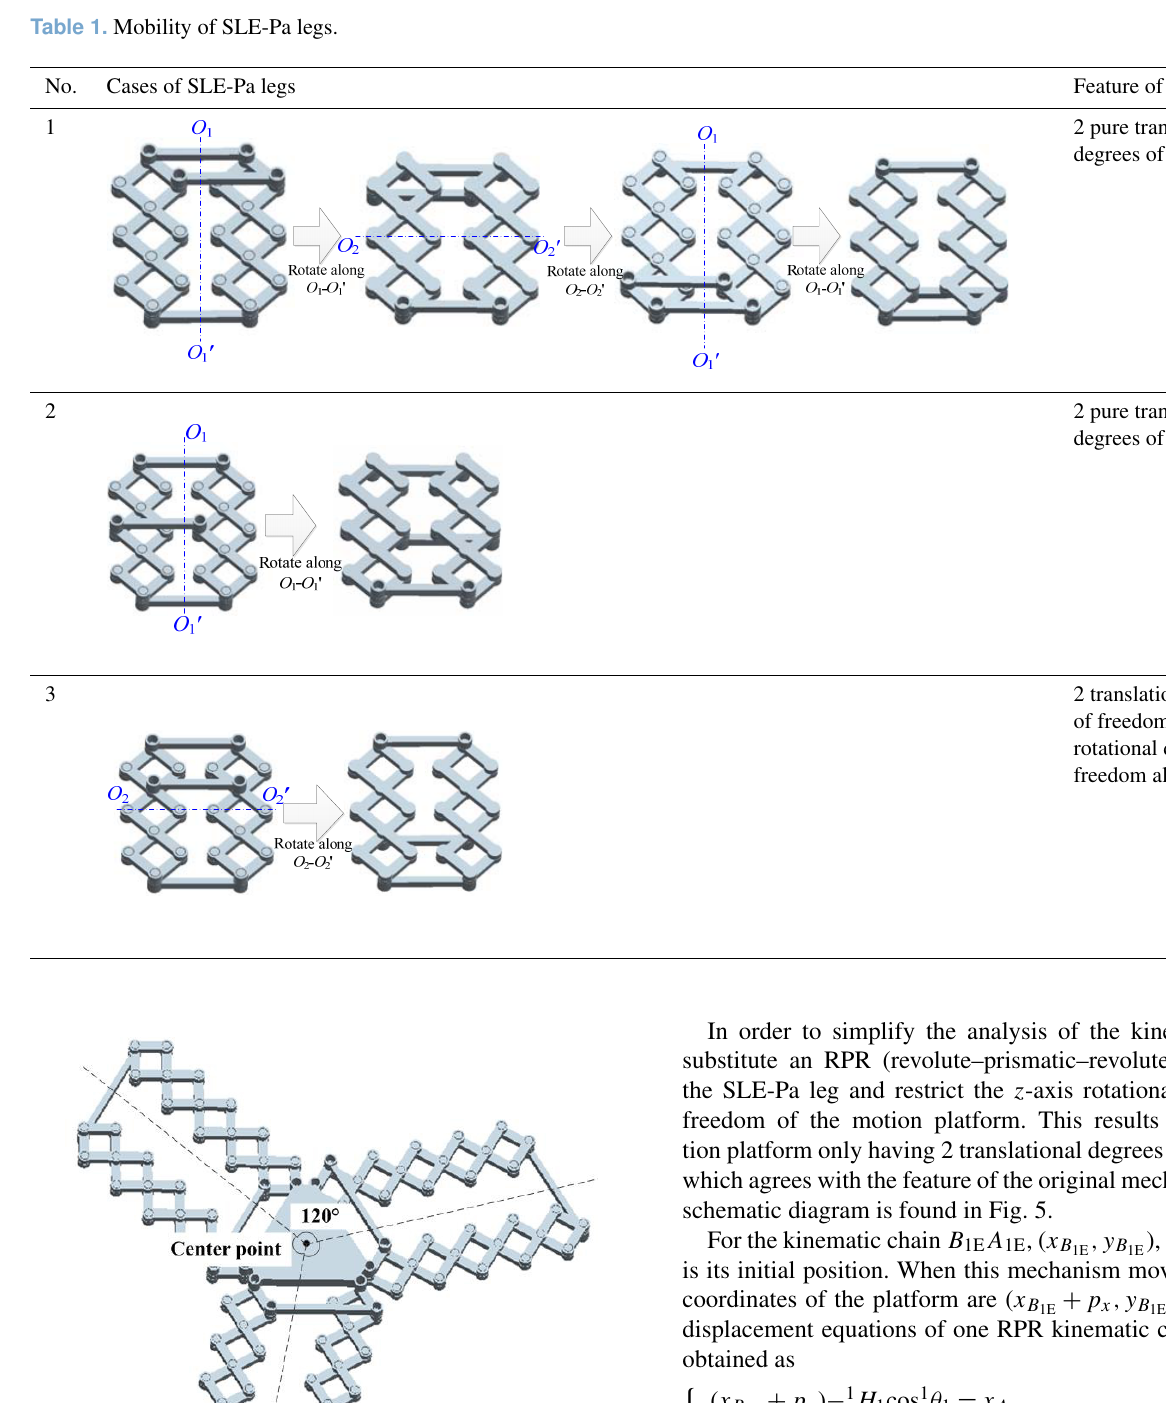
Table 1. Mobility of SLE-Pa legs. No. Cases of SLE-Pa legs